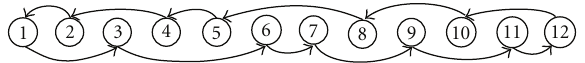
Figure 3: Final computed graph representing the extracted